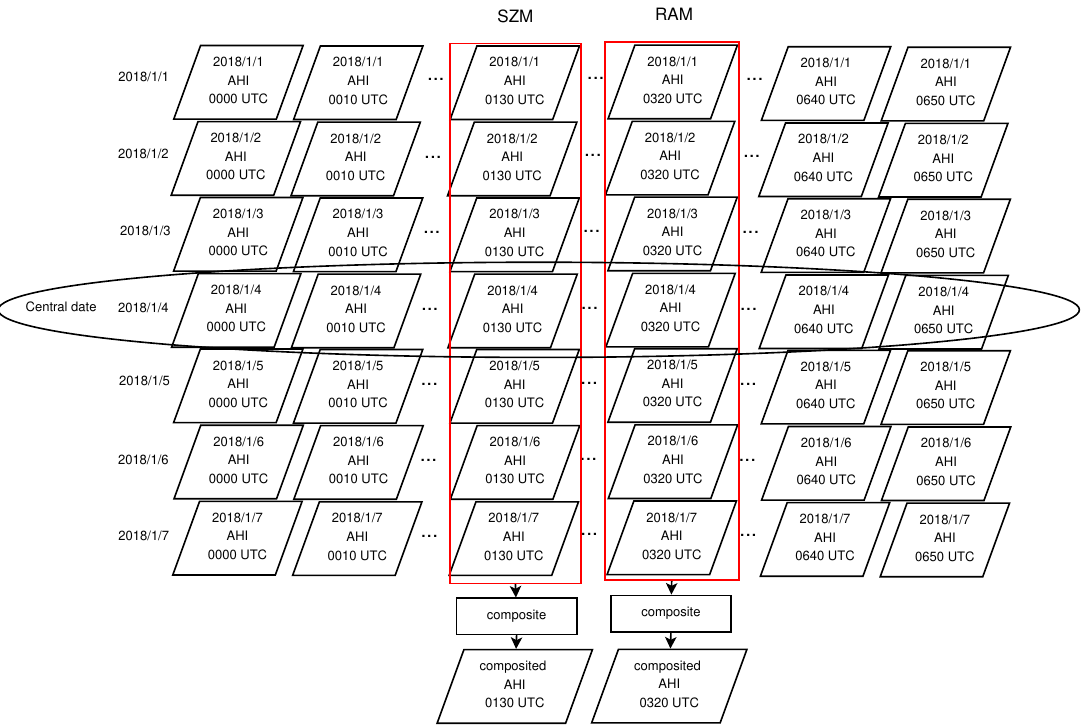
Figure 5. Overview of the AHI data composite. AHI data collected over seven consecutive days were used to create a single image for each of the SZM and RAM methods (for a total of two images). The SZM and RAM images differed with respect to the data acquisition time. The central date of the AHI observation period is the same as that designated for the MODIS